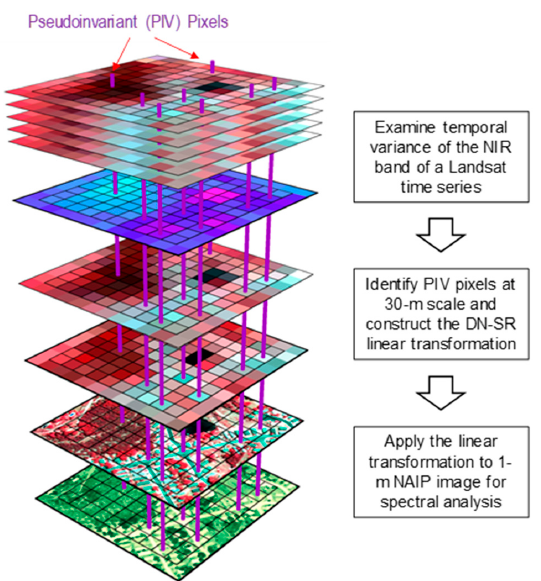
Figure 2. The conceptual diagram of the pseudoinvariant near-infrared threshold (PINT) method. DN and SR stand for digital number and surface reflectance, respectively.